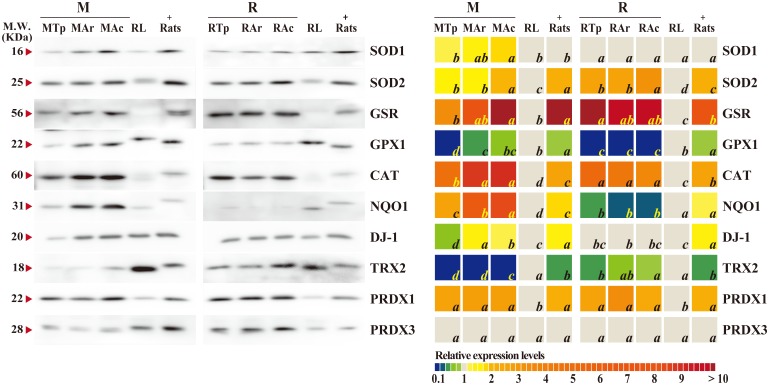
Relative expression levels of antioxidant enzymes.Left panel shows Western blot band intensity of SOD1, SOD2, GSR, GPX1, CAT, NQO1, DJ-1, TRX2, PRDX1, and PRDX3 in M. ricketti bats (M), R. ferrumequinum bats (R), non-hibernating R. leschenaultia bats (RL), and rats. The bands of rats are used as positive controls (+) for antibody reaction. MTp, MAr, and MAc represent M. ricketti bats at the torpor, arousal, and active states, respectively. RTp, RAr, and RAc indicate R. ferrumequinum bats at their torpor, arousal, and active states, respectively. Predicted molecular weights (KDa) are denoted by red arrowheads. Right panel is a heat map showing relative expression levels of antioxidants from 0.1 to >10. The band density of each detectable protein of RL is set as 1 and is shown in gray. The relative expression level of a protein is calculated by dividing its band density value by that of RL. Values of group means are represented by italicized letters and are in the order of a > ab > b > bc > c > d. The difference in value is significant (P < 0.05) between different letters.